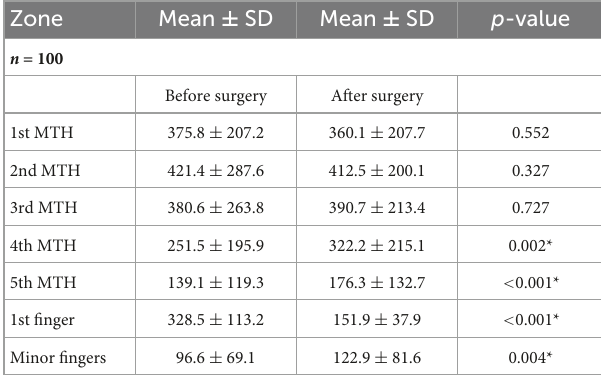
TABLE 1 Modification of pre and post-surgical mean pressure values.